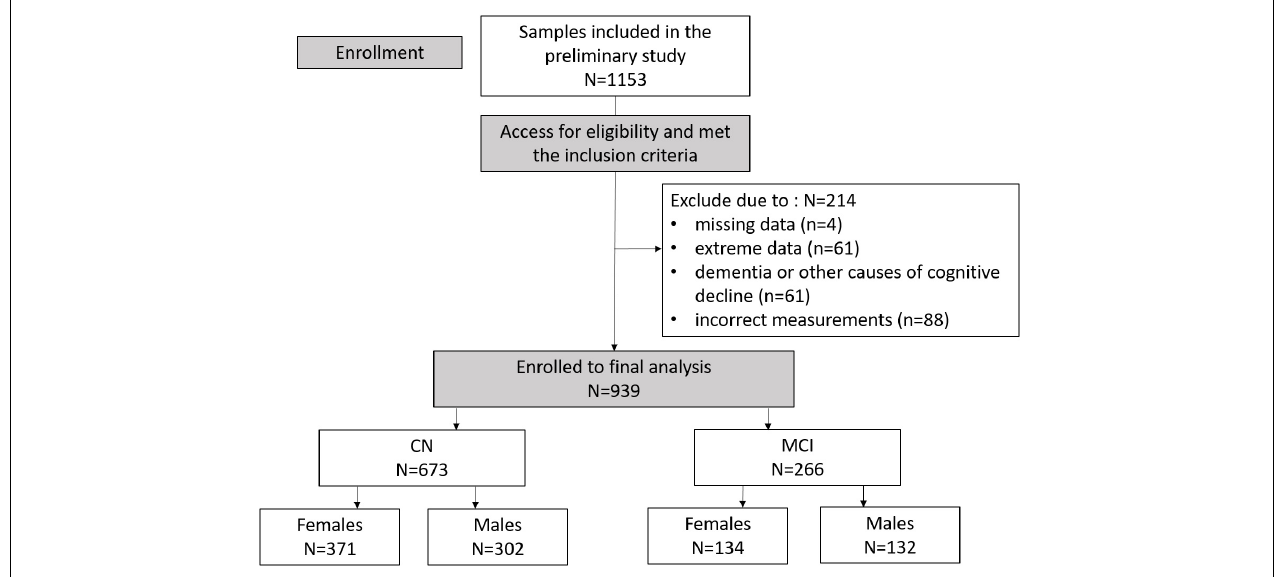
FIGURE 1 | Consolidated Standards of Reporting Trials (CONSORT) diagram illustrating enrollment and exclusion criteria for this